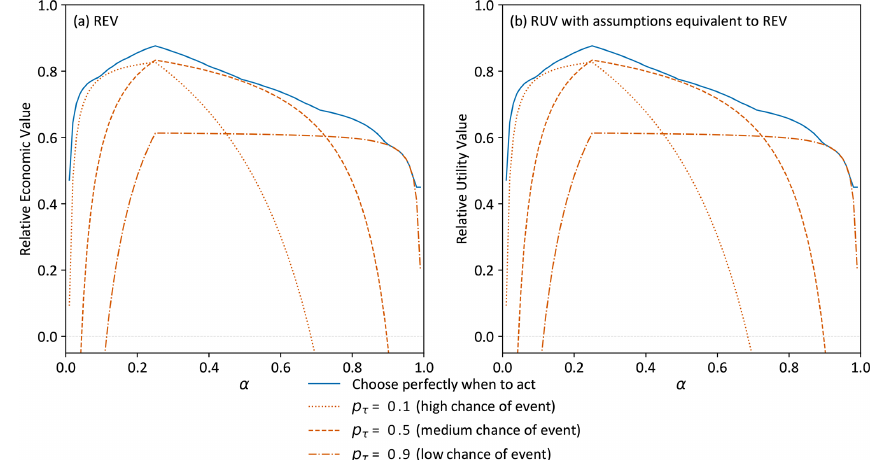
Figure 4. Forecast value quantified using (a) REV and (b) RUV with assumptions enforced and the threshold approach for decision-making. A binary decision of flow exceeding the top 25% of observations, subseasonal forecasts from the first week of lead times, and a risk-neutral user. Critical probability thresholds for the four curves are the value leading to maximum forecast value and the 0.1, 0.5, and 0.9 forecast quantile corresponding to acting when there is a high, medium, or low chance of event occurring, respectively.